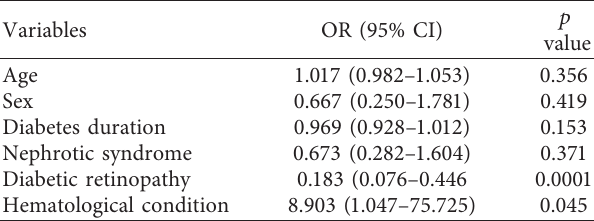
Table 3: Multivariate logistic regression model for the prediction of NDKD as a main diagnosis at kidney